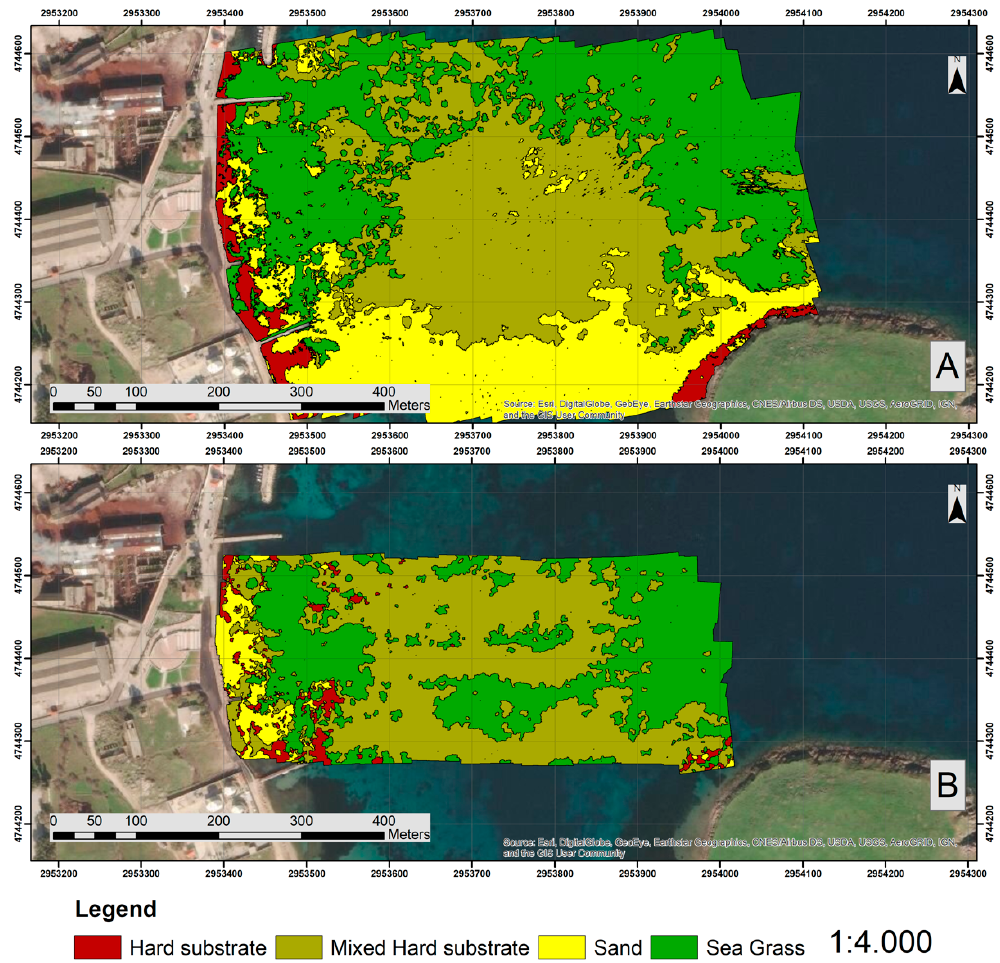
Figure 9. Classification maps for the orthomosaic of the study area applying the fuzzy rules: ( A ) tc-RGB orthomosaic map and ( B ) multispectral orthomosaic map.